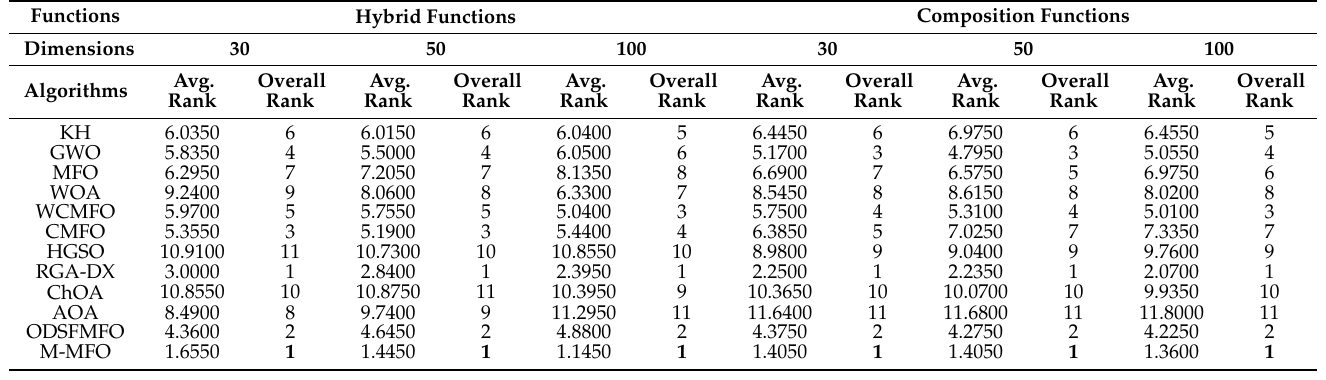
Table 9. Friedman test for hybrid and composition functions of the CEC 2018.